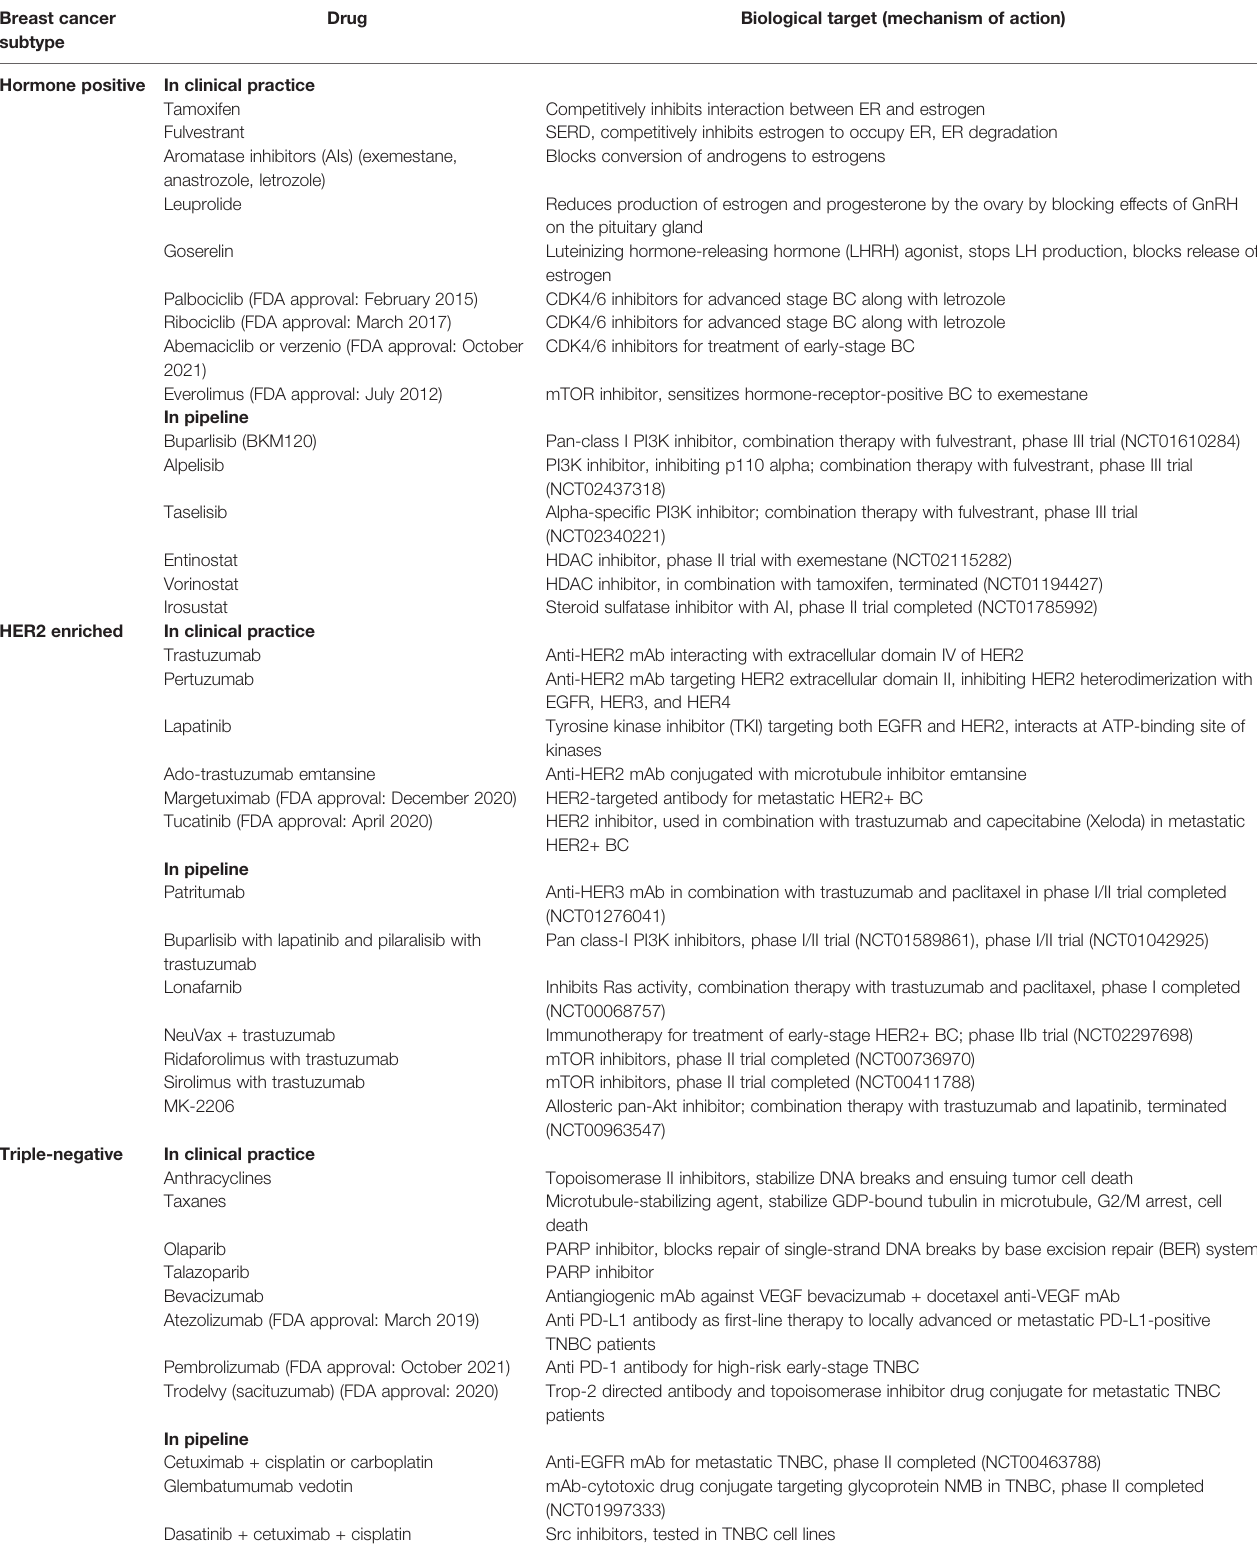
TABLE 1 | Different chemotherapeutic modalities in clinical practice and novel therapeutic drugs being developed against BC subtypes and their mechanism of action. Breast cancer